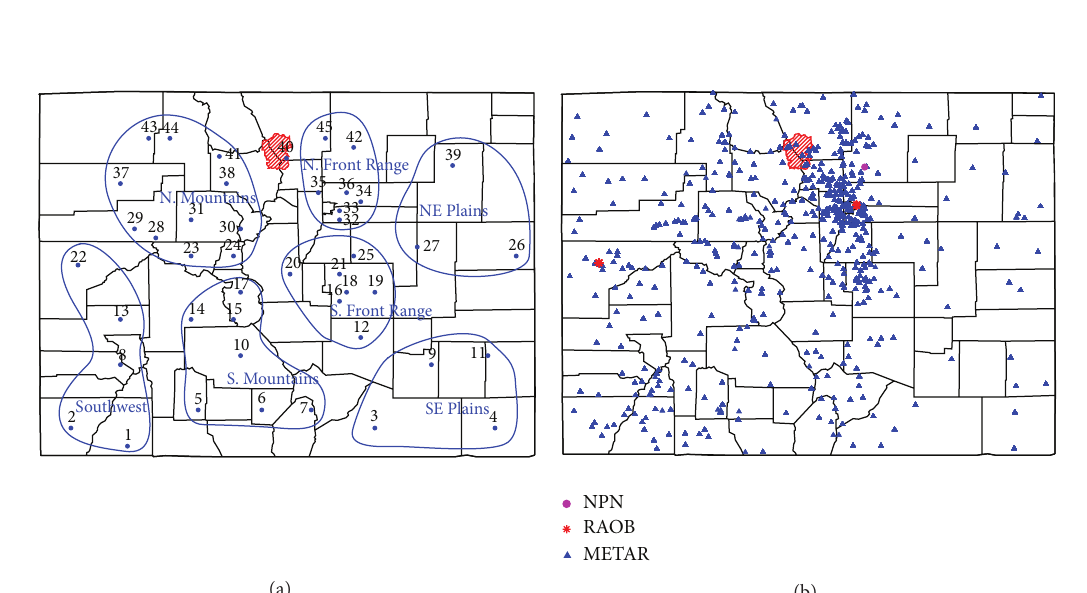
Figure 2: Colorado (450km north-south by 610km east-west) with county boundaries and sites of meteorological observations. Panel (a) shows sites in NCAR’s DS461.0 dataset. The red hatched area is RMNP. Site 40 on the eastern edge of RMNP is the RoMANS core site. The remaining sites were grouped as shown for WRF model assessment. Panel (b) shows locations of some MADIS data including locations of the NOAA profiler network (NPN), radiosonde observations (RAOB) and hourly surface (METAR)